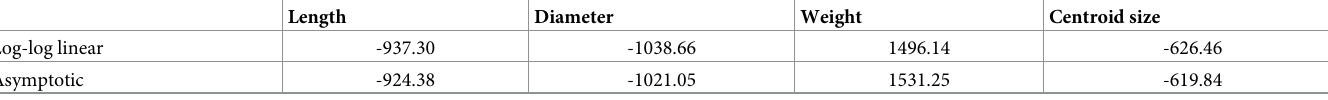
Table 4. Bayesian Information Criterion (BIC) for each